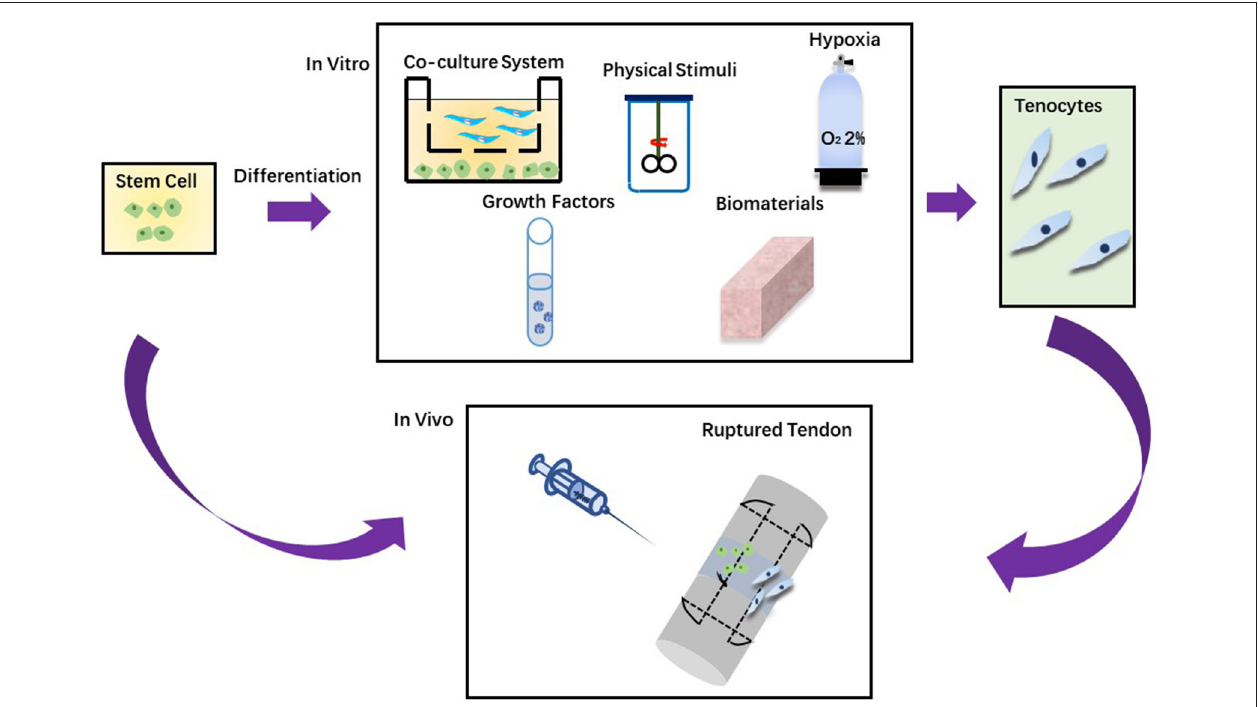
FIGURE 2 | Two approaches in stem cell therapy. (A) Stem cells are injected directly into the injured tendon. (B) Stem cells are grown in vitro to differentiate into tenocytes and then injected into the injured